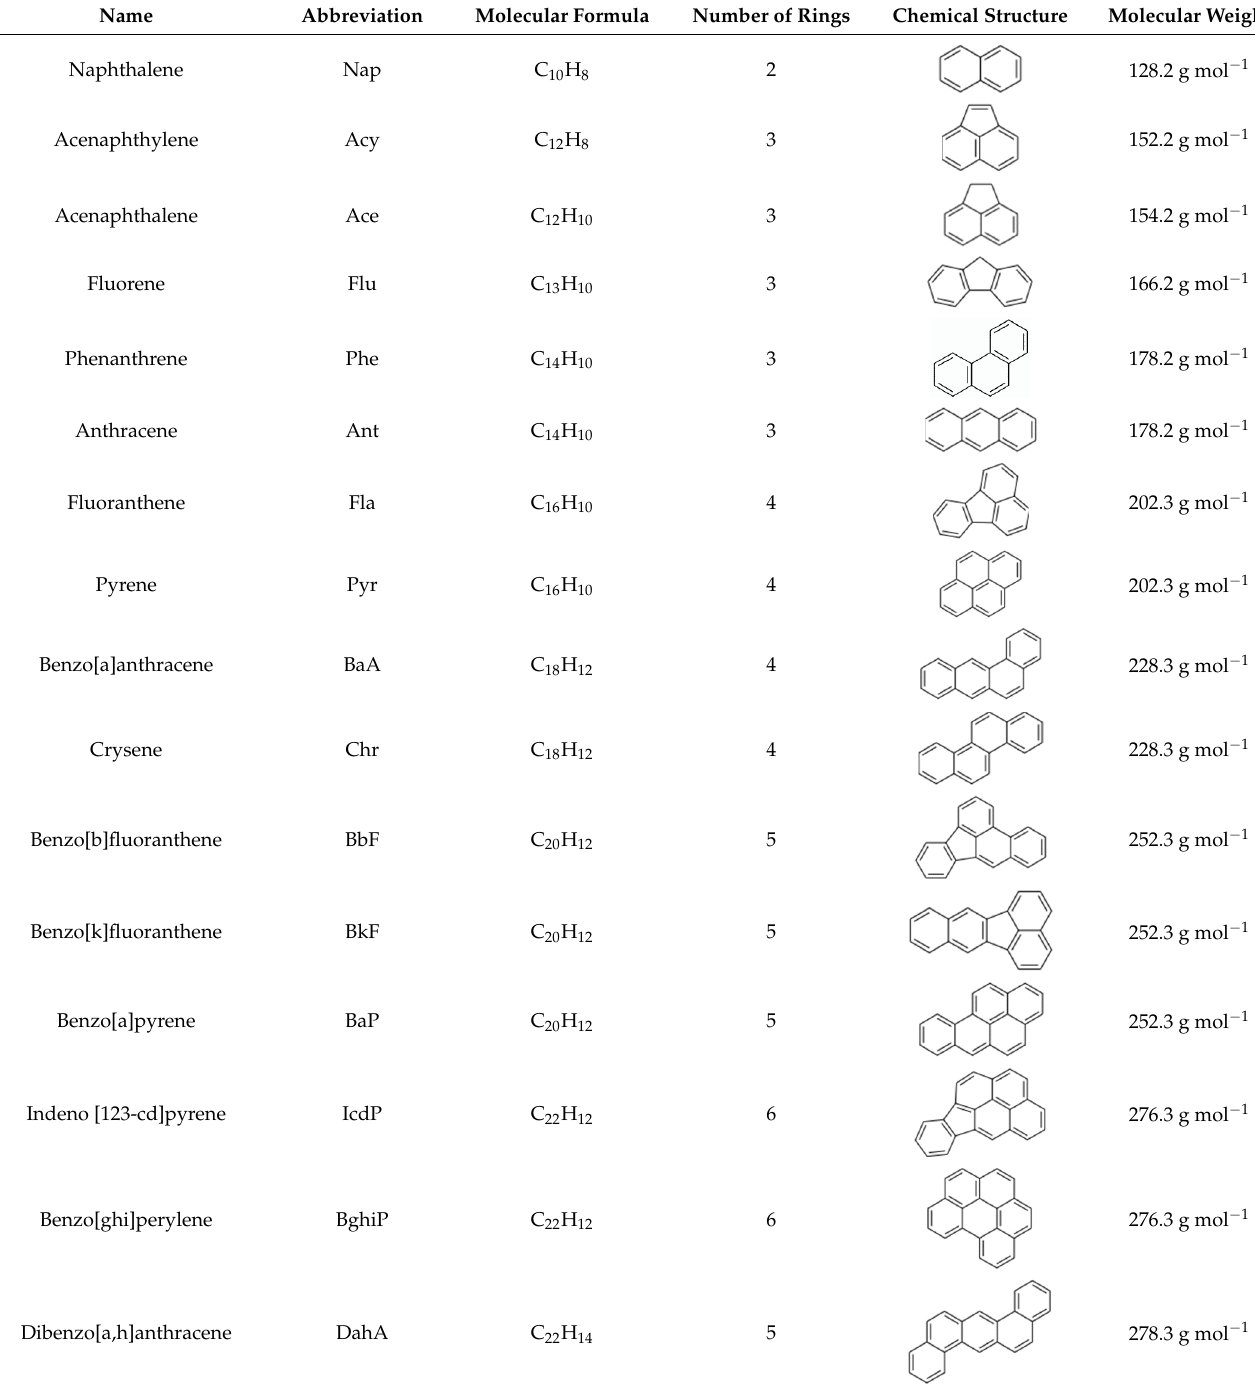
Table 4. The 16 Priority PAHs according to the United States Environmental Protection Agency (US EPA) and the World Health Organization (WHO) [20,44].